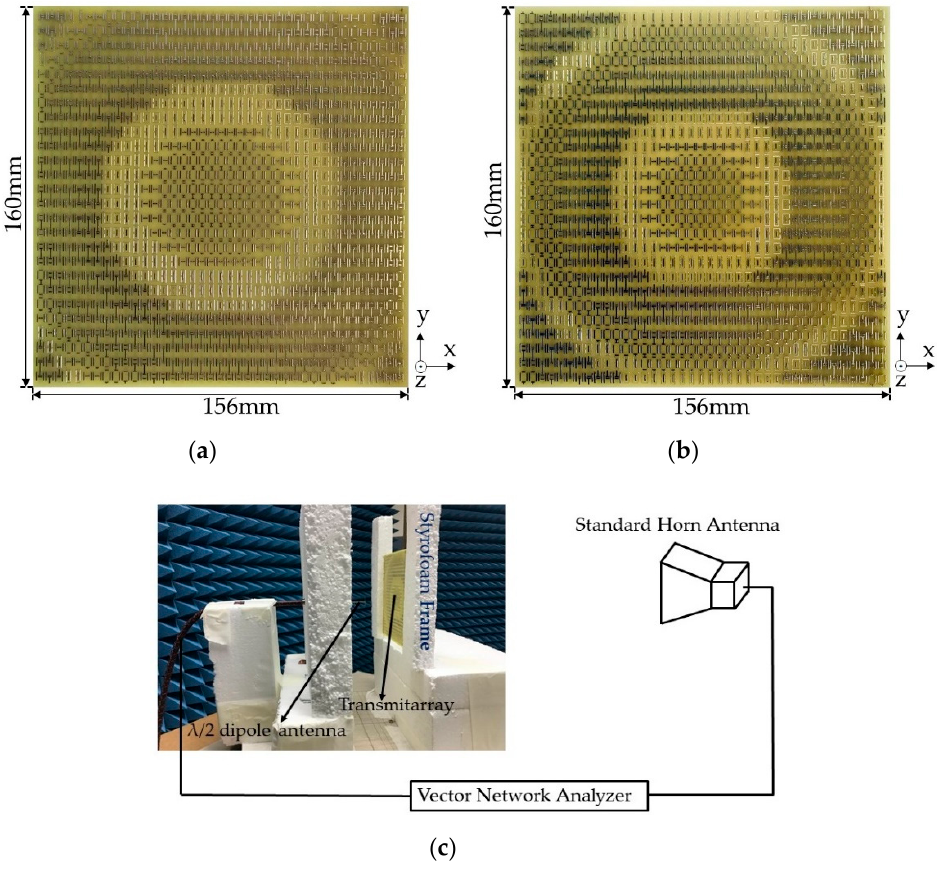
Figure 13. Top view of the fabricated focusing lenses with ( a ) 100 mm focal distance and ( b ) 60 mm focal distance. ( c ) Setup for measuring the focusing gain of the focusing lens using a half-wave dipole antenna as the feeding source and a standard horn antenna. Both antennas were connected to a vector network analyzer.